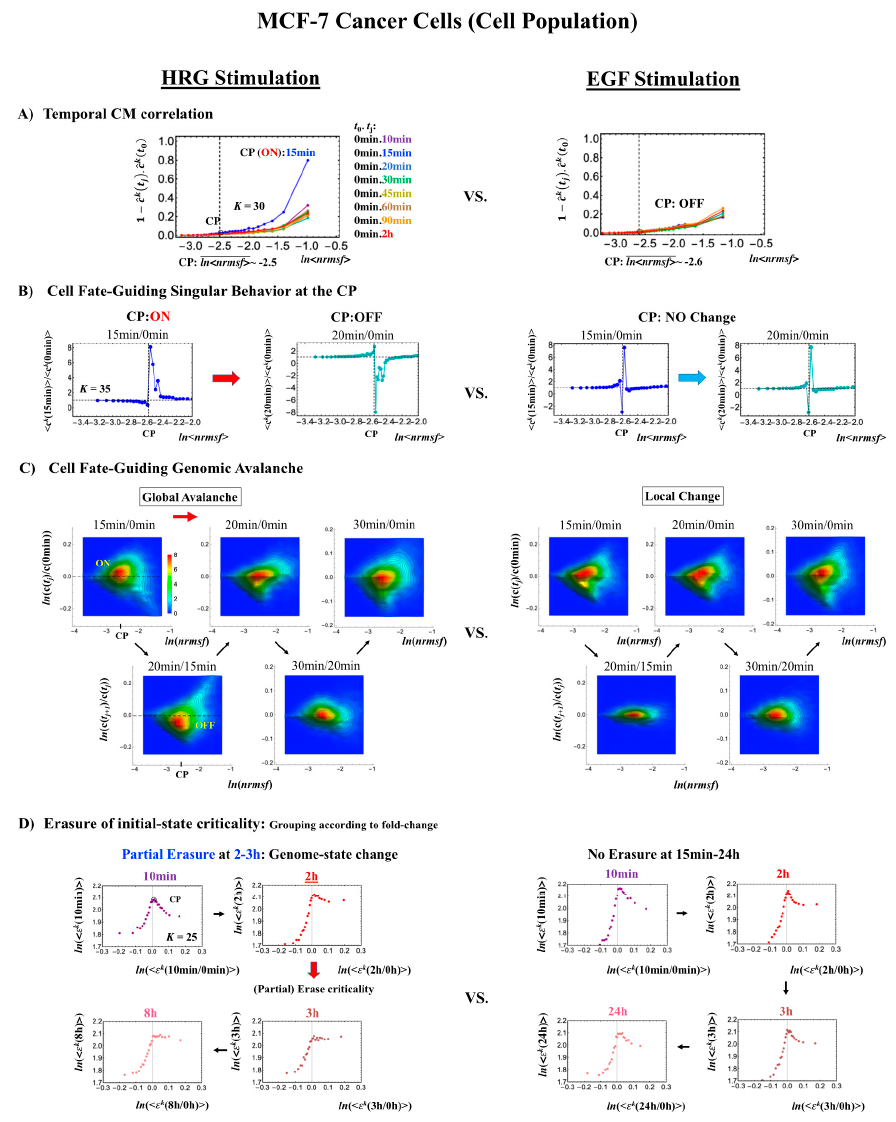
Figure 4. HRG- (left) and EGF-stimulated (right) MCF-7 cell-population responses. The CM correlation analyses reported in this figure are relative to gene groups ordered along their relative nrmsf : in ( A ), temporal CM correlation ( x- axis; see Section 4.2.2): 1 − (cid:1855)̂ (cid:3038) (cid:3435)(cid:1872) (cid:3037) (cid:3439).(cid:1855)̂ (cid:3038) ((cid:1872) (cid:2868) ) ( y -axis) is evaluated. At 15 min, the correlation response for HRG stimulation diverges from other responses, indicating that the CP is activated between 10 and 15 min for HRG, whereas for EGF stimulation, such a distinctly diverging correlation response does not occur (i.e., the CP is inactivated). Activation or inactivation of the CP marks the occurrence of cell differentiation for HRG and only proliferation (no differentiation) for EGF. Panels ( B ) and ( C ) provide direct evidence of the ON/OFF state of the CP. ( B ) The transition of the higher-order structure of the CP occurs for 15–20 min as shown in the fold- change from the initial time point. The swolled coil state (dominant positive fold-change: y -axis) at 15